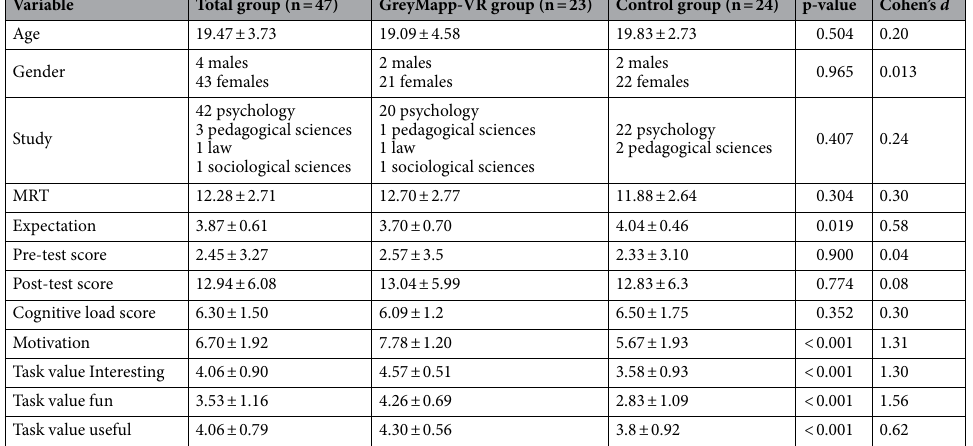
Table 2. Baseline characteristics per group and p-values of the inductive statistics. MRT Mental rotation test, VR Virtual